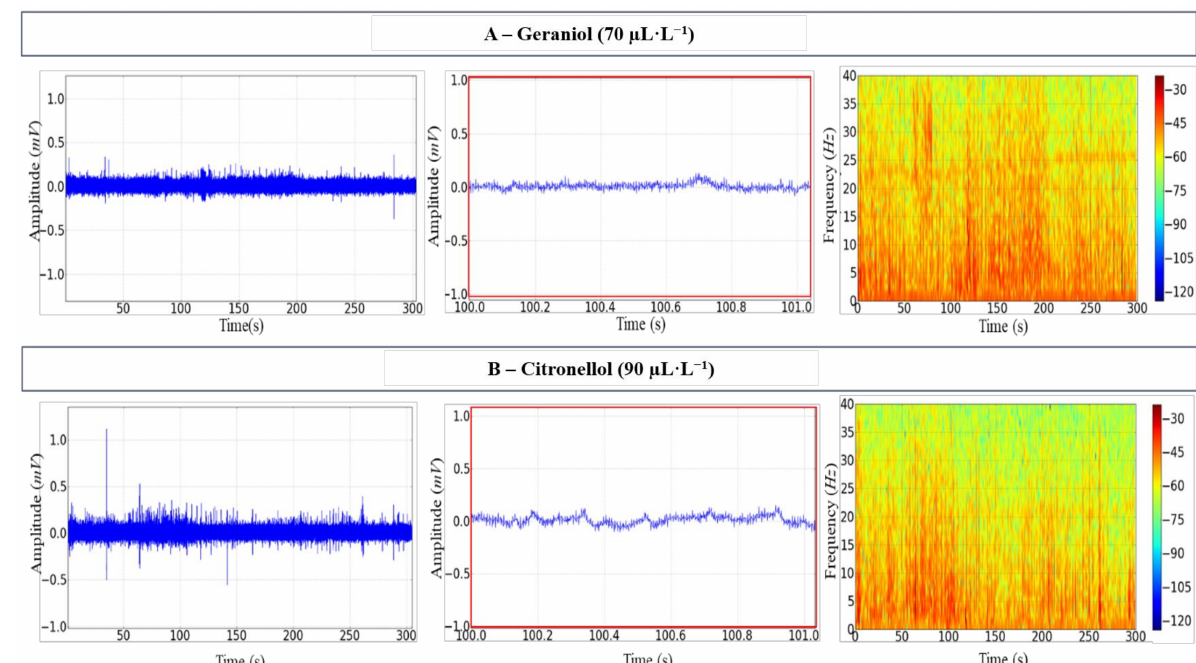
Figure 2. Electroencephalographic (EEG) recordings of the Tambaqui C. macropomum midbrain during induction. ( A ) The 70 µ L · L − 1 geraniol records over 300 s (left); 1 s snapshot amplification (centre); the spectrogram of frequency showing the distribution of power (right). ( B ) The 90 µ L · L − 1 citronellol records over 300 s (left); 1 s snapshot amplification (centre); the spectrogram of frequency showing the distribution of power (right). Amplification of 5000 × . Records from one fish only in each